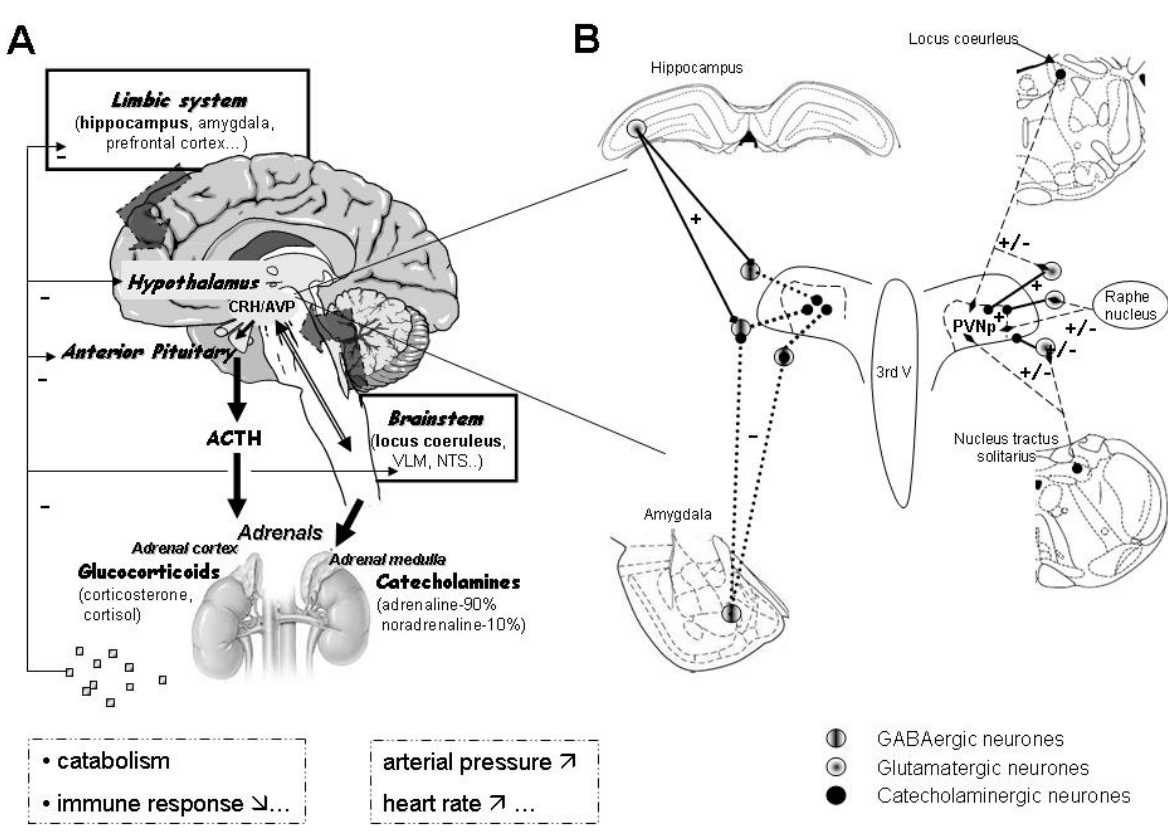
FIGURE 1 . Functional anatomy of the stress response. (A) Stressful situations activate various brain structures, including the limbic system and brainstem, which results in the stimulation of the hypothalamic paraventricular nucleus (PVN). PVN neurons release corticotrophin-releasing hormone (CRH)/arginine-vasopressin (AVP) that induce adrenocorticotropin hormone (ACTH) secretion from the anterior hypophysis. In turn, ACTH acts on the adrenal cortex and triggers glucocorticoid (GC) liberation. These steroid hormones target various organs to mobilize energy and control the brain via a negative feedback. In parallel, sympathetic brain areas located in particular hypothalamic (PVN) and brainstem nuclei (nucleus tractus solitarius, etc.) control the catecholamine release from adrenal medulla chromaffin cells. Adrenaline and noradrenaline target organs to induce an adapted physiological response to acute stress. (B) Detail of the fine regulation of PVN. The parvocellular part of PVN is controlled by a neuronal microenvironment composed of GABAergic and glutamatergic neurons. These interneurons as well as CRH neurons are the targets of regulatory inputs coming from hippocampus (glutamatergic afferences), amygdala (GABAergic afferences), locus coeruleus and nucleus tractus solitarius (noradrenergic afferences), and raphe nucleus (serotoninergic afferences). Indeed, the hippocampus exerts a strong tonic regulatory modulation via activation of mineralocorticoid receptors (MR) that bind plasma GC with a high affinity. These receptors are mainly occupied in basal situation when the plasma GC levels are low (Reul and de Kloet, 1985[269]). In stressful situations, the rise in GC affects both hippocampal MR and GC receptors (GR), and thus inhibits the activity of PVN cells. The hippocampal GR are involved in the phasic inhibition of PVN; there are parts of the feedback control of the HPA axis. PVN is also targeted by noradrenergic inputs arising from the locus coeruleus and nucleus tractus solitarius; these noradrenergic fibers directly or indirectly modulate the activity of CRF/AVP cells. In fact, the PVN is surrounded by a “microenvironment” composed by GABAergic and glutamatergic interneurons. Among other brain areas that are known to modulate the PVN in stress, the amygdala and the prefrontal cortex project in or around the PVN, thus exerting inhibitory or excitatory stimulations on PVN. Scheme adapted from Herman et al. (2002) ( Pharmacol. Biochem. Behav. , 71 ,